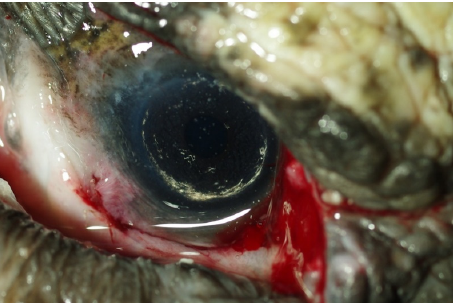
Figure 6. Post-surgery view of the right eye. After dissection of nictitans and adhesions between the palpebral and bulbar conjunctiva and cornea, the eyeball appeared